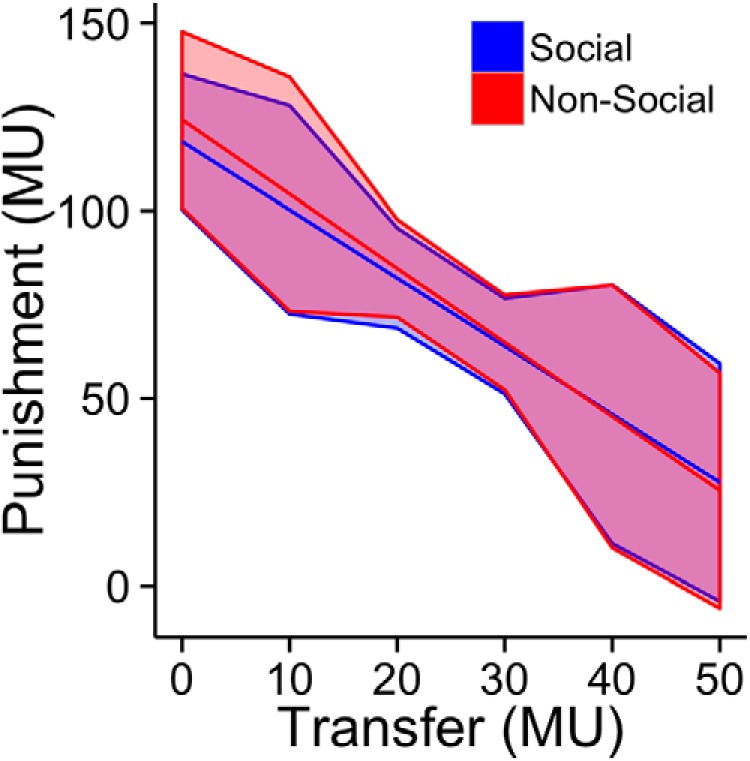
The plot shows punishment distributions as a function of amount transferred for both social (blue) and nonsocial groups (red). Punishment was regressed onto transfers up to 50 MUs, with the predicted punishment (thick line) and the SDs of the residuals (shaded area) for each transfer amount. Transfers >50 MU resulted in zero punishment. The overlapping distributions for the social and nonsocial treatments indicate that the computer algorithm was successful in replicating human punishment behavior.